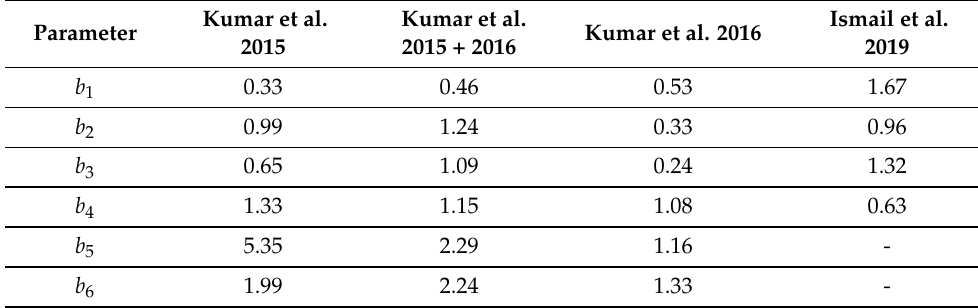
Table 2. Model parameter values obtained for fitting on different datasets.